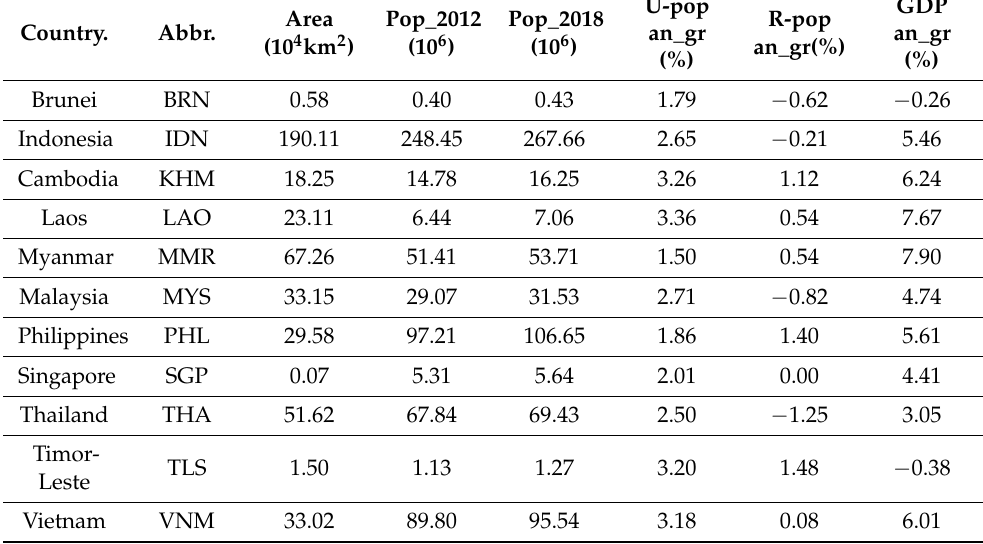
Table 1. The basic information for 11 countries in Southeast Asia (SEA), including name abbreviation (Abbr.), area, 2012 and 2018 population (pop), 2008–2017 annual growth rate (an_gr) of urban population (U-pop), 2008–2017 annual growth rate of rural population (R-pop), and 2008–2017 annual growth rate of gross domestic product (GDP). The data are collected from the DataBank of World Bank (https://data.worldbank.org.cn/ (accessed on 26 January 2021)).